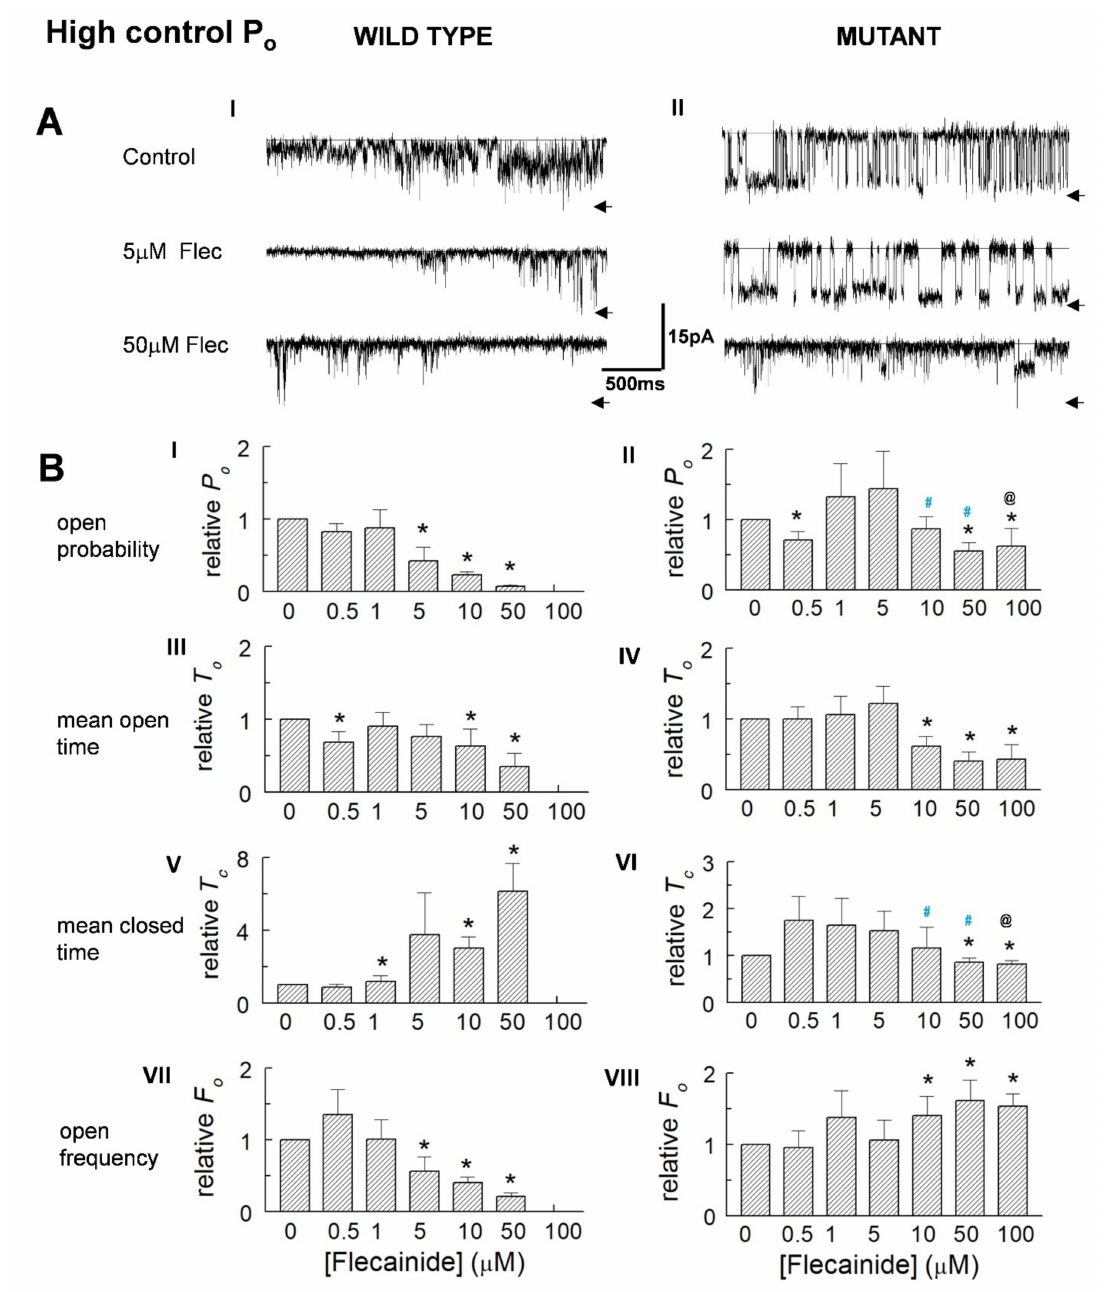
Figure 3. Reduced activity of high control P o WT and P2328S channels. ( A ) Currents at − 40 mV from channels with control P o = 0.188 (wild type (WT), ( A ) (I) or 0.494 (P2328S, ( A ) (II)), before flecainide (upper) and with flecainide at 5 µ M (middle) and 50 µ M (lower). Arrows indicate maximum open current. ( B ) Relative open probability ( P o ) ( B ) (I,II), mean open time ( T o ) ( B ) (III,IV), mean closed time ( T c ) ( B ) (V,VI) and open frequency ( F o ) ( B ) (VII,VIII). Data is mean ± SEM. Asterisk (*), significant ( p < 0.05) change from control. Blue # , significant ( p < 0.05) difference between P2328S and WT, @ significant ( p < 0.05) differences between 0.5 or 1 µ M and 100 µ M flecainide. WT ( n = 3) and P2328S ( n =